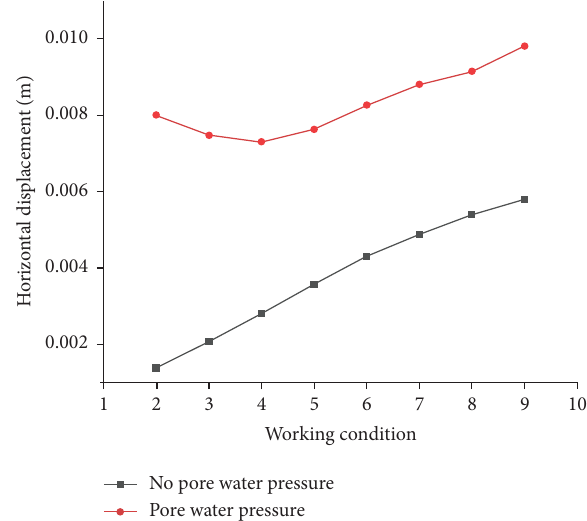
Figure 28: Maximum deformation of the underground diaphragm